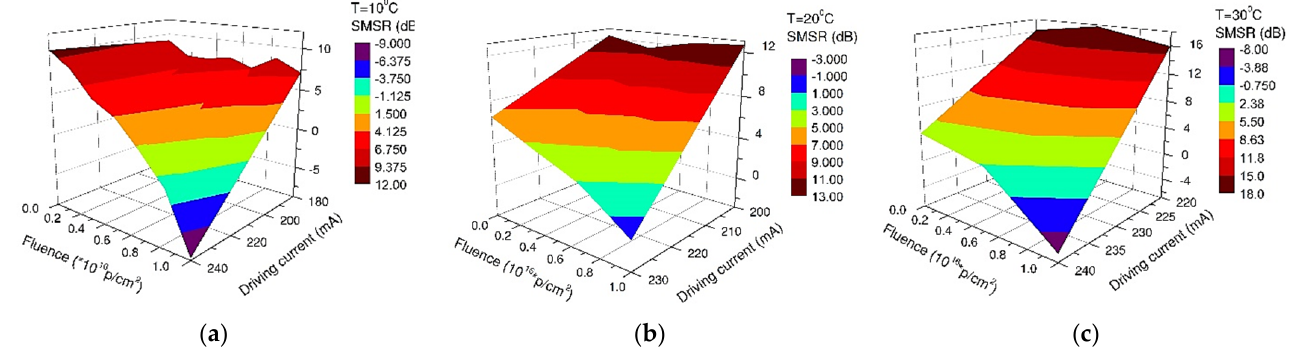
Figure 7. Decrease in the SMSR with the irradiation and driving current for the operating tempera- tures: ( a ) 10 °C, ( b ) 20 °C, ( c ) 30 °C. The QCL’s beam quality and lower fluences (e.g., 10 14 to 10 15 p/cm 2 ) provide quite